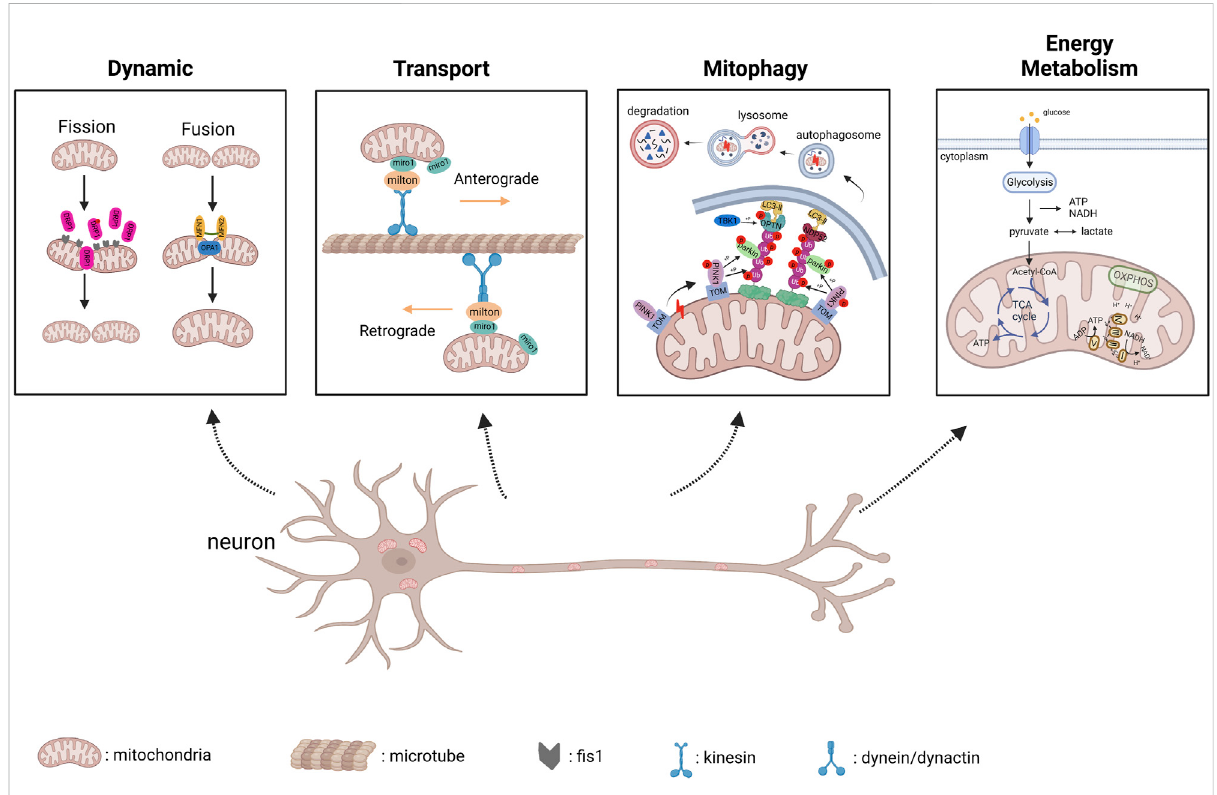
FIGURE 1 Physiological progress of mitochondrial dynamics, transport, PINK1/parkin-mediated mitophagy and energy metabolism (created with BioRender.com). 1) Dynamic: DRP1 is recruited to mitochondrial membrane along with Fis1 to regulate mitochondrial fi ssion; MFN1/2 mediates fusion of mitochondrial outer membrane and OPA1 mediates fusion of inter membrane. 2) Transport: Anterograde transport is mediated by kinesin motorandMiro/Miltonadaptors,andretrogradetransportismediatedbydynein/dynactinandMiro/Miltonadaptors.3)PINK1/parkin-mediated Mitophagy: Once mitophagy starts, PINK1 accumulates in mitochondria, and in turn results in PINK1 autophosphorylation, which subsequently triggers ubiquitin phosphorylation, and recruits parkin to damaged mitochondria; Parkin ubiquitinates mitochondrial outer membrane proteins,